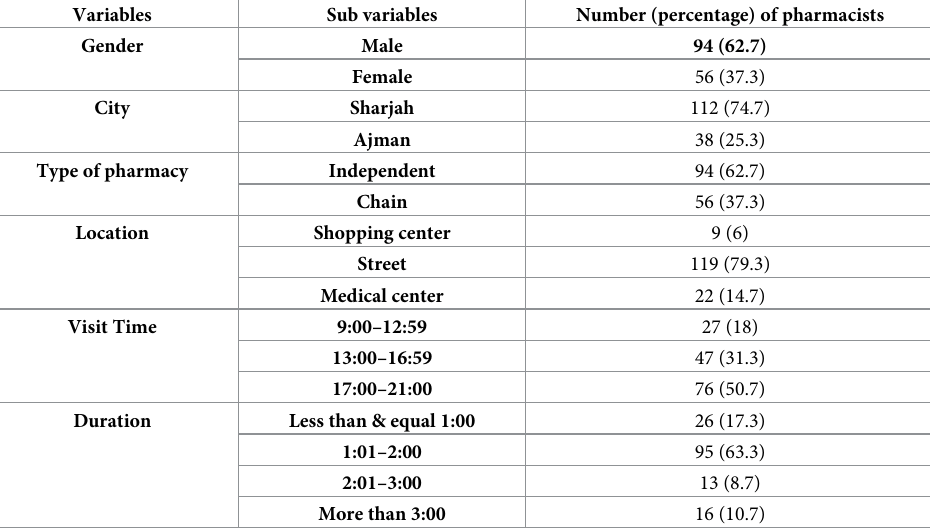
Table 2. Pharmacy and pharmacist-related information (n =